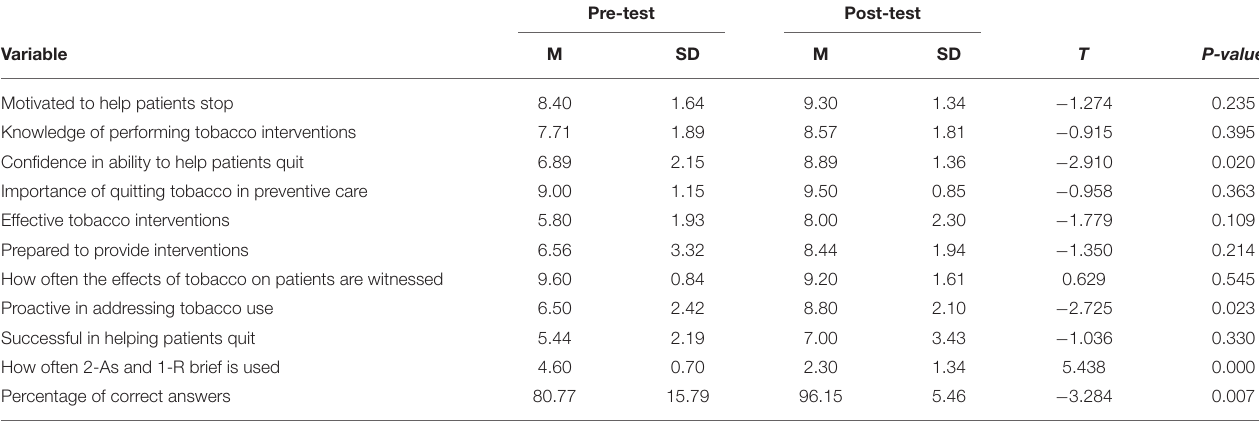
TABLE 2 | Paired sample t -Test results: effective training is the key factor to increasing provider performance and proficiency in delivering brief tobacco